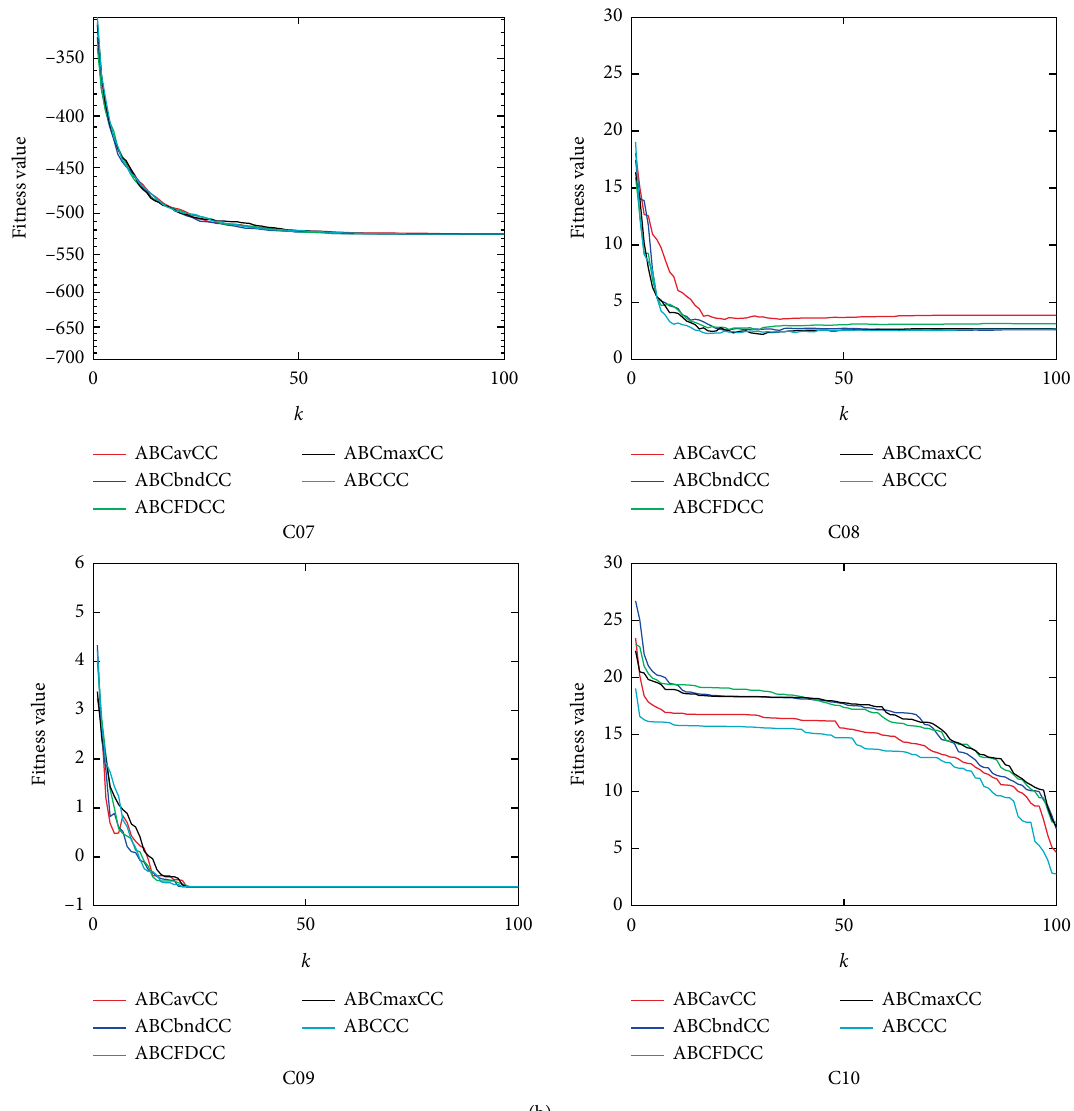
Figure 4: Average convergence of the five methods (10-